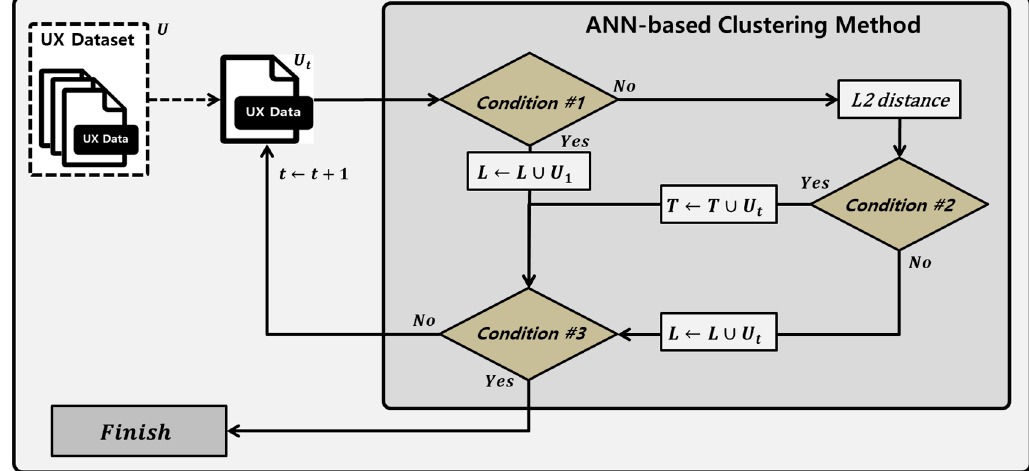
Figure 4. Flowchart of ANN-based clustering method.